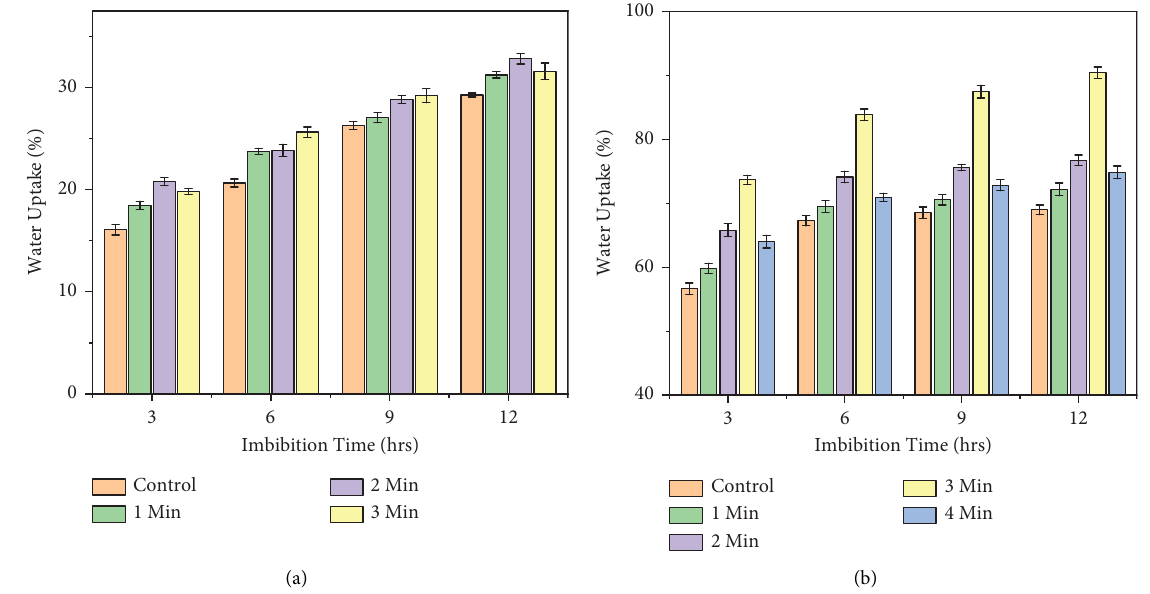
Figure 19: Evolution of Imbibition rate in (a) radish and (b) carrot seeds due to CAPP